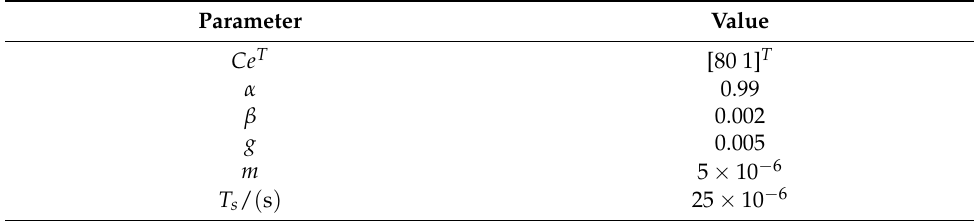
Table 3. Parameters of the DSVC+DDC.